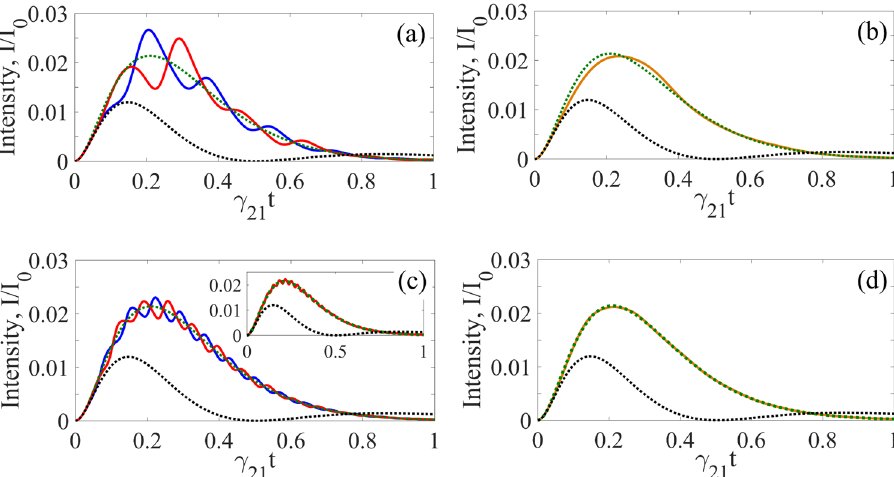
E S (δ S ) from Eq. (31) for the same as in Fig. 3 vibrating absorber: ˜